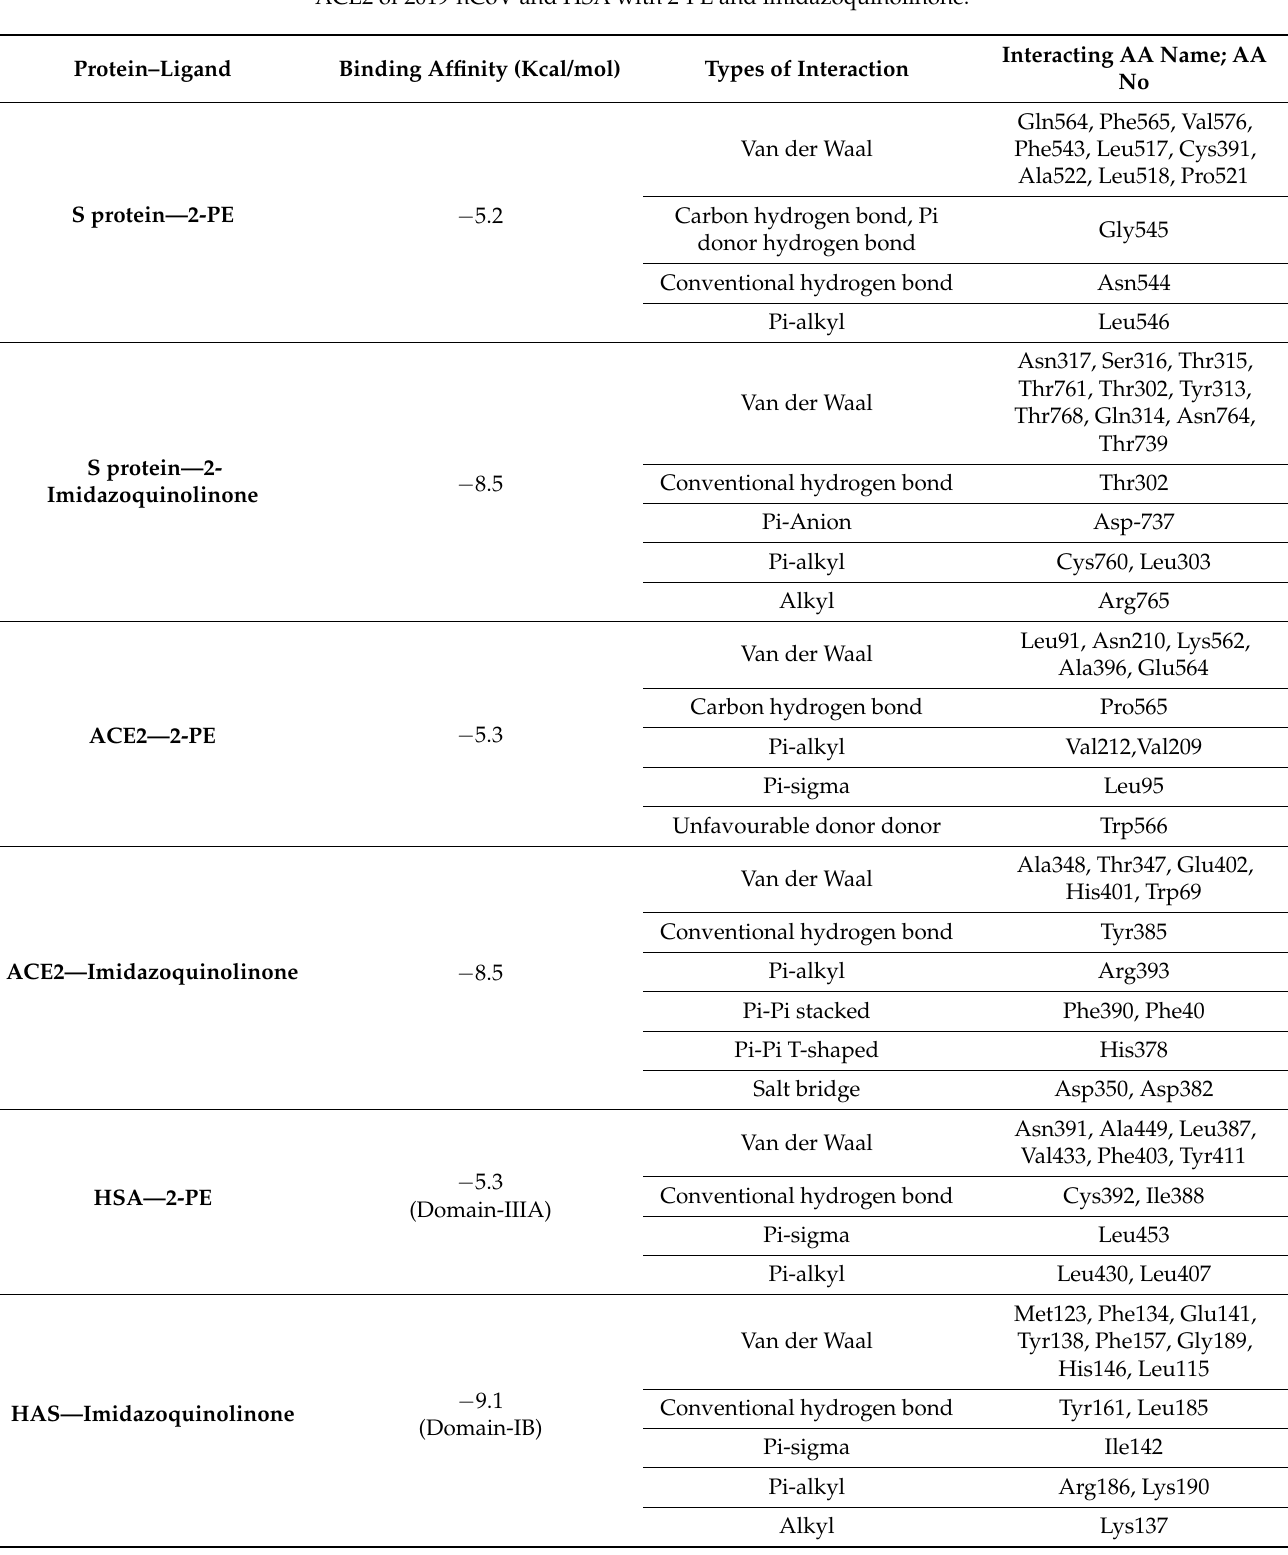
Table 1. The binding energy, interaction type, and amino acid involved in the interaction of S protein ACE2 of 2019-nCoV and HSA with 2-PE and